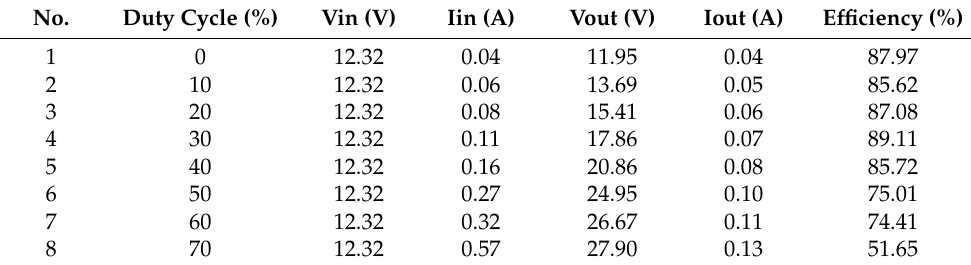
Table 6. Test result boost mode.